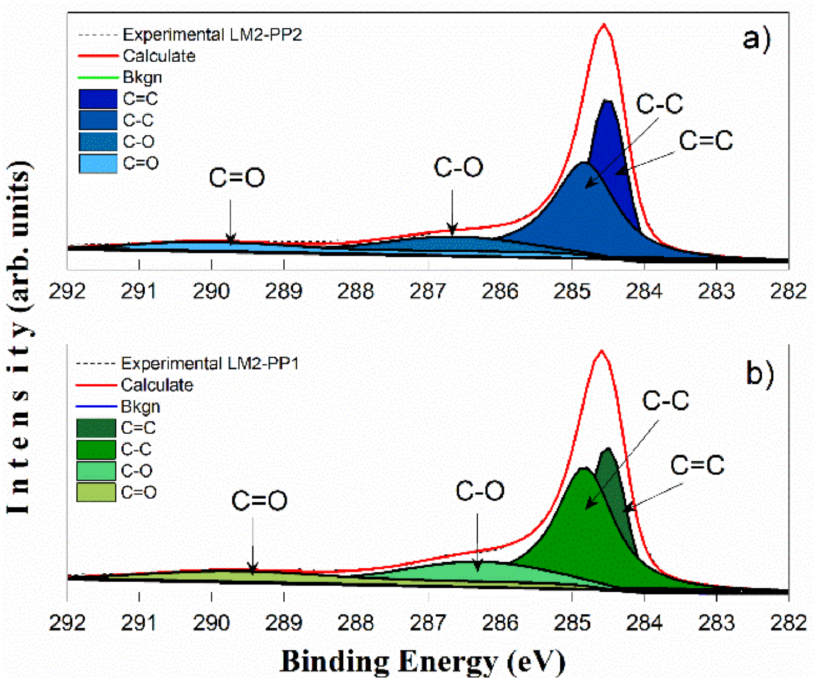
Figure 11. C 1s X-ray photoelectron spectra of the PP1 ( a ) and PP2 ( b ) processing of LM2 samples. Table 4. Summary chart with area percentages of the C 1s XPS spectra for the different treatments.